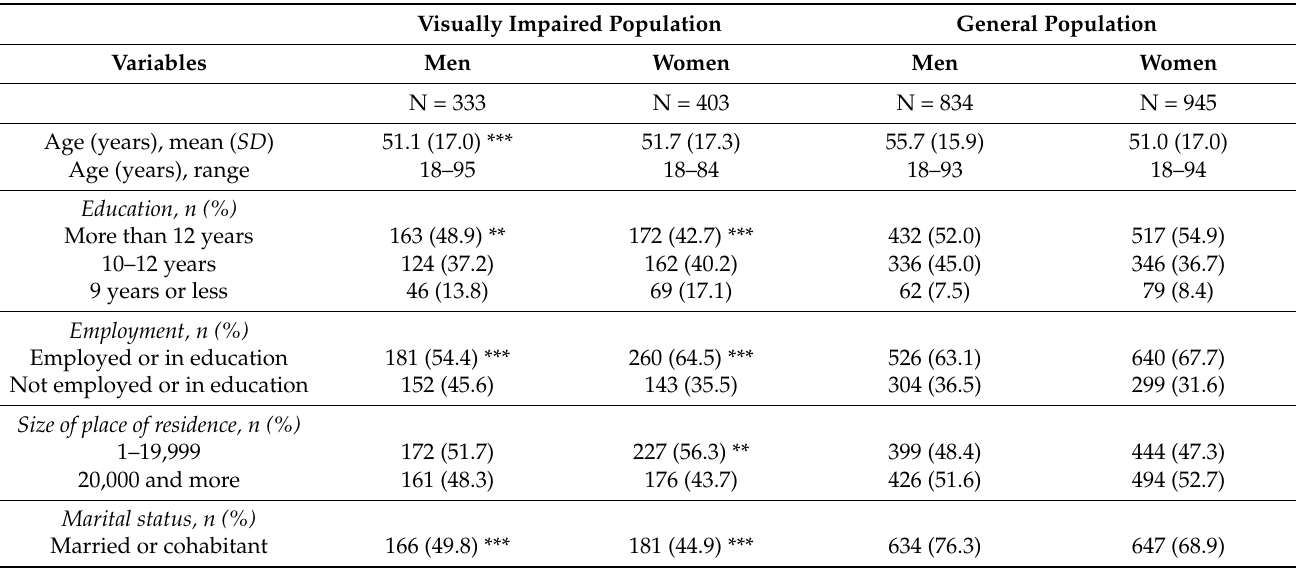
Table 1. Sociodemographic characteristics of the participants (VI n = 736 and GP n = 1792). Visually Impaired